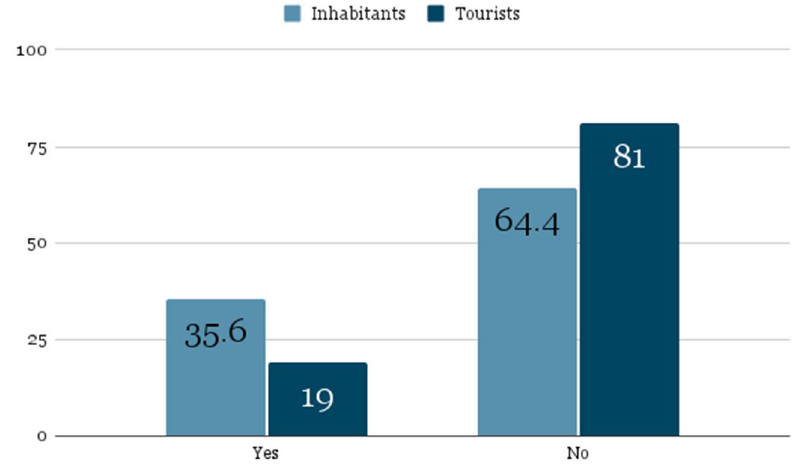
Figure 4. Distribution of surveys. Source: own elaboration.